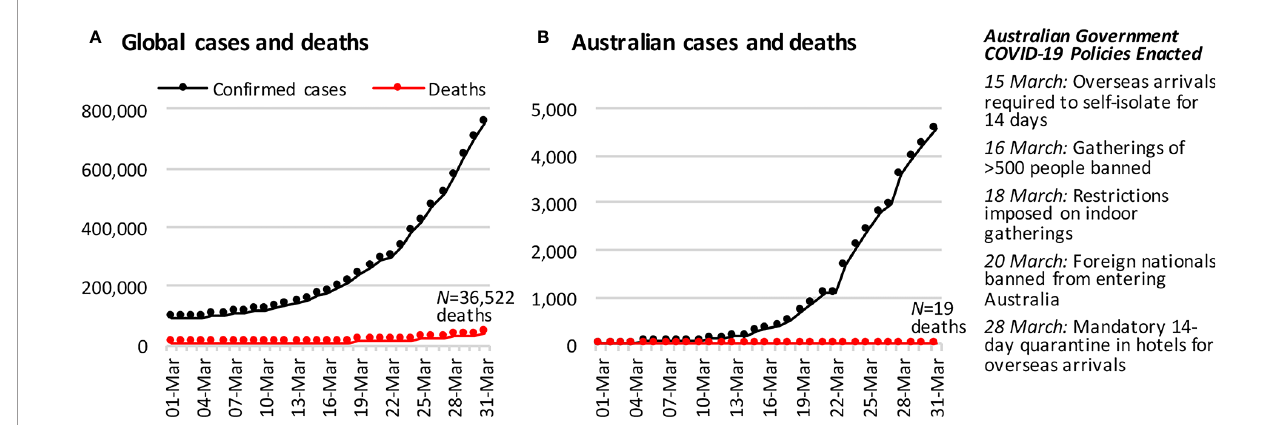
FIGURE 1 | The cumulative number of COVID-19 con fi rmed cases and deaths (A) across the globe and (B) in Australia, in the month leading up to the fi rst survey wave of this study. Case and death data are from